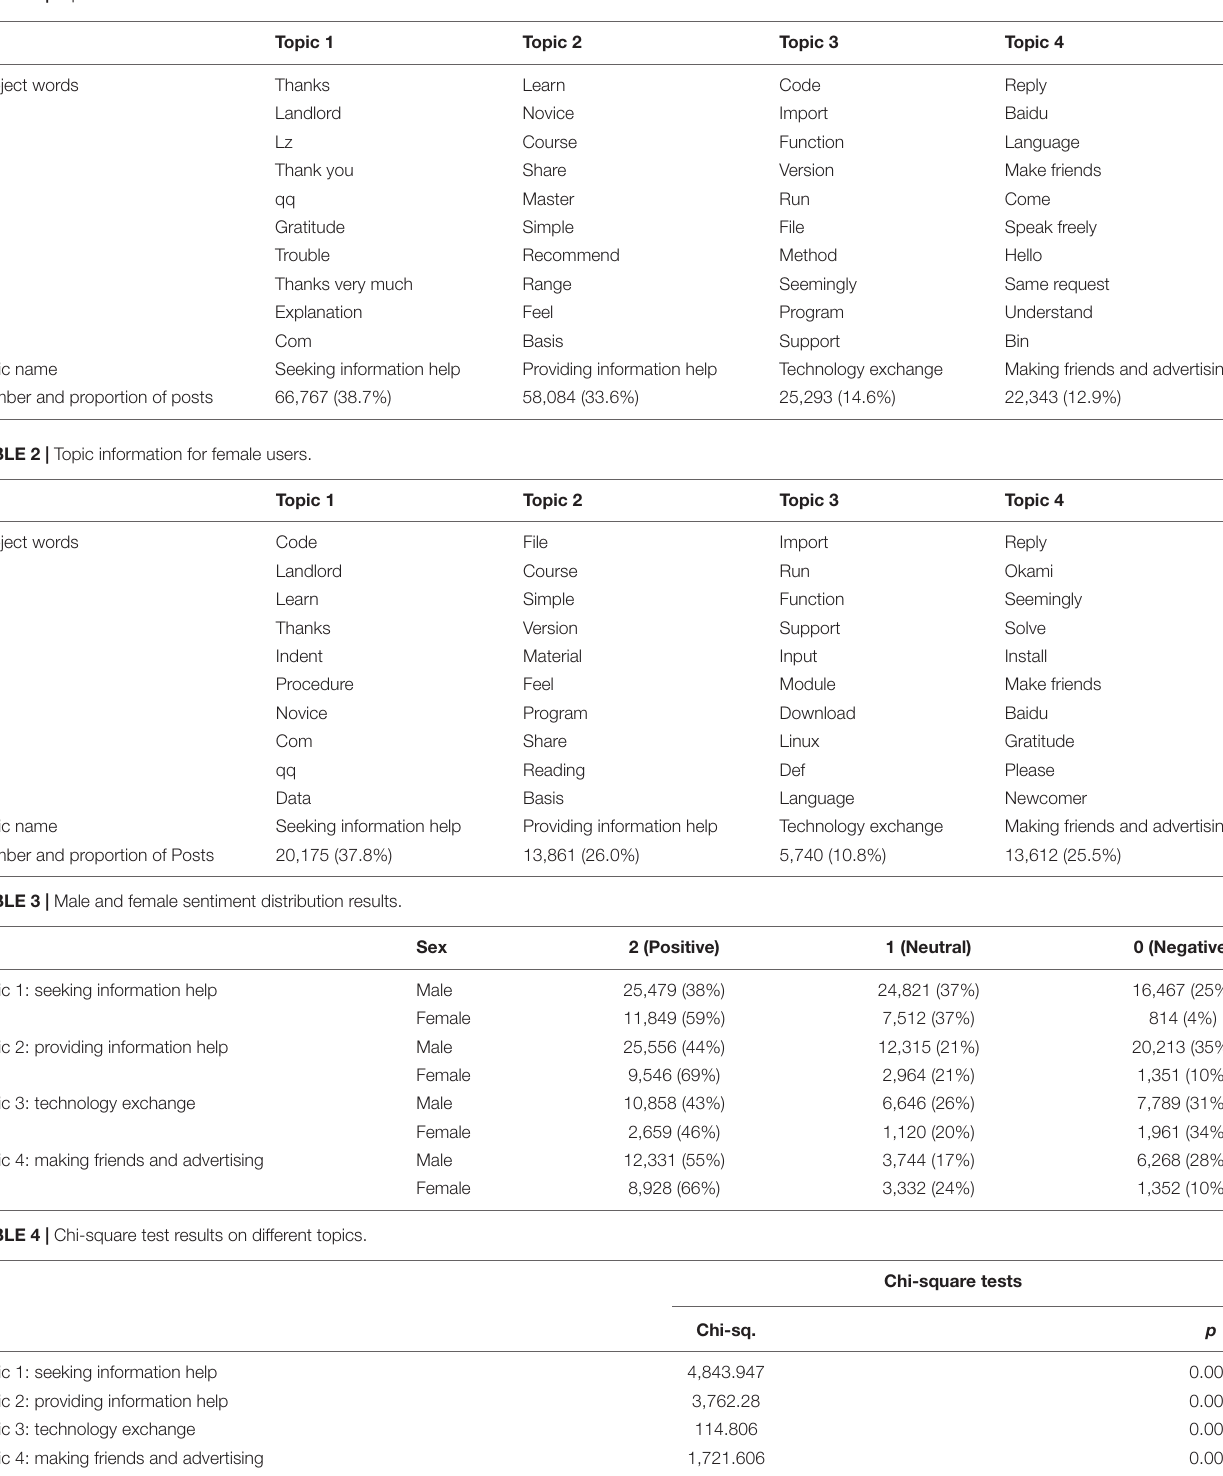
TABLE 1 | Topic information for male users.